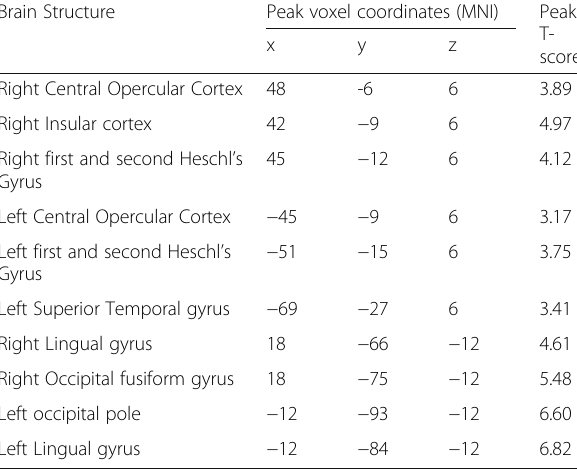
Table 3 Increased functional connectivity in MA compared with MO Brain Structure